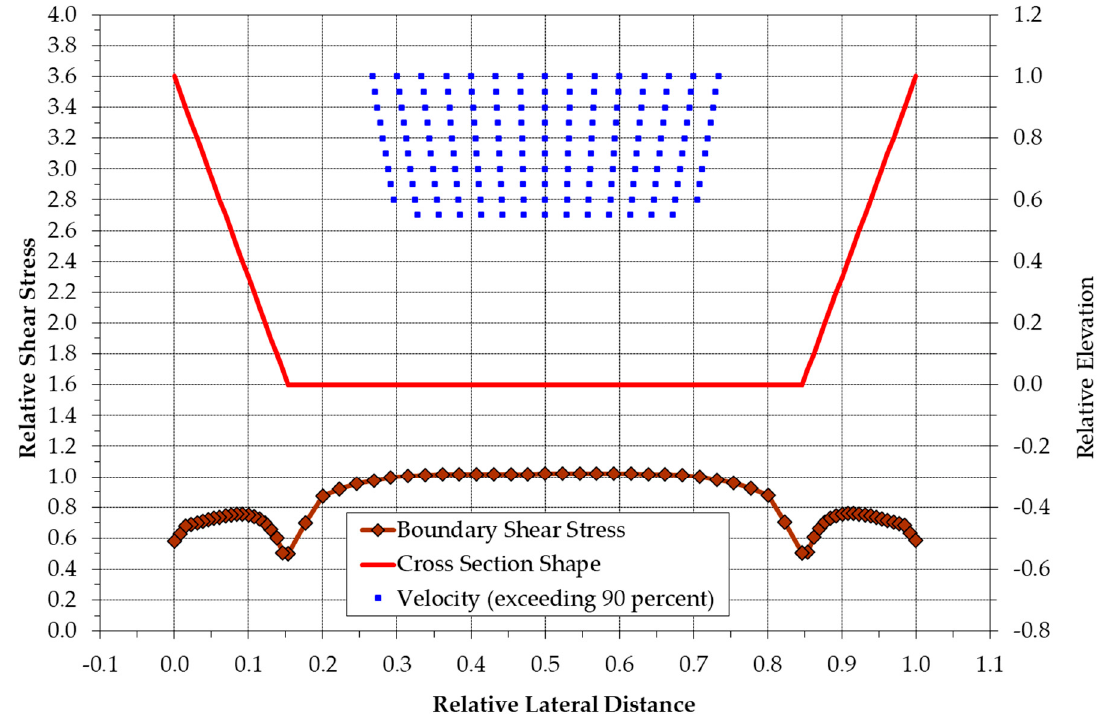
Figure 33. Cross-section 112 (upstream straight reach) lateral distribution of shear stress and zone where velocity is at least 90 percent of the maximum velocity.